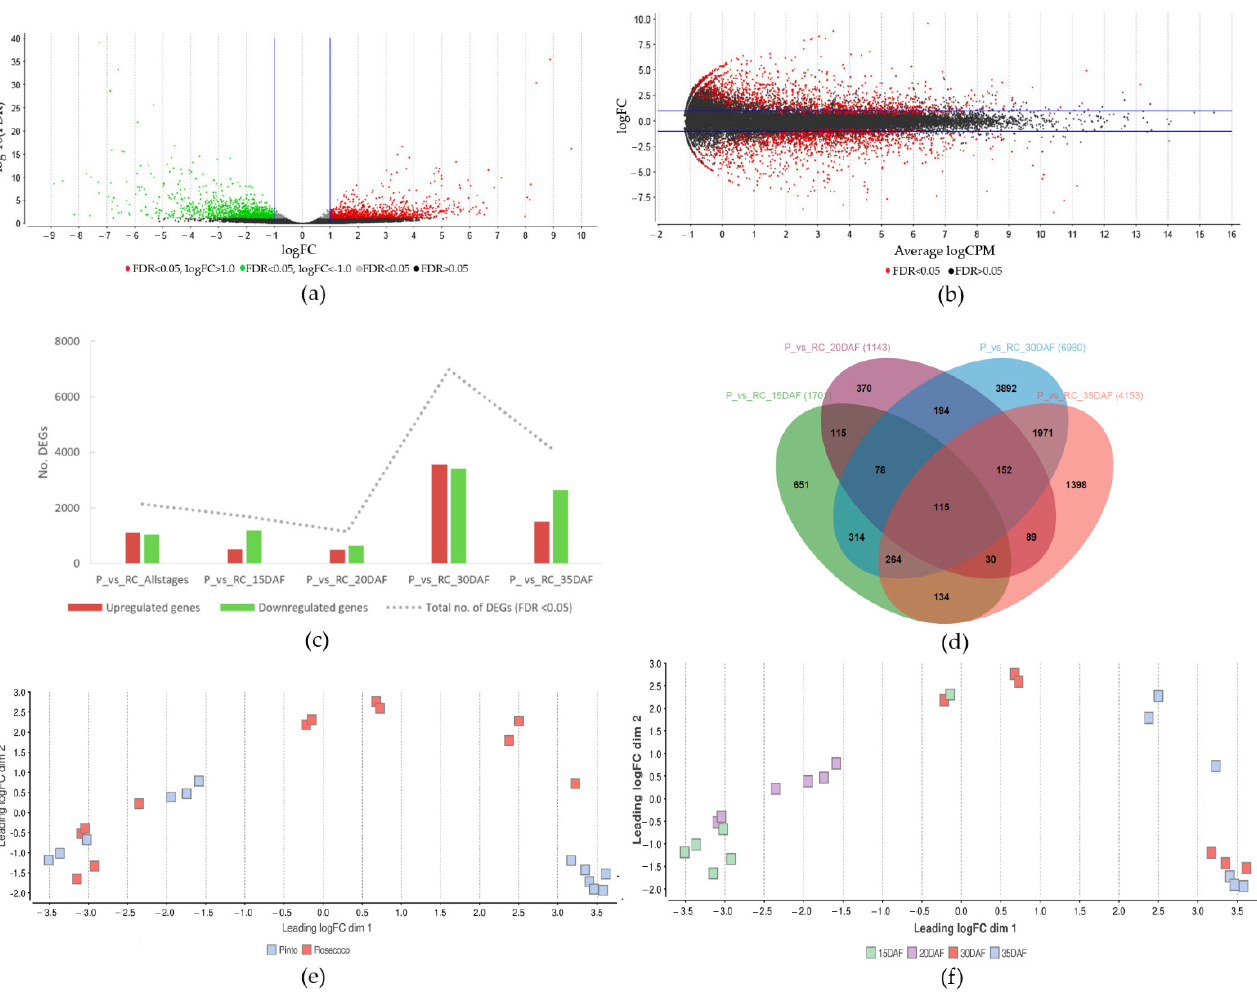
Figure 6. Results of the differential gene-expression analysis showing the distribution of samples and DEGs. ( a ) Volcano plot showing the log2 fold change in expression between slow-cooking beans (Pinto) and fast-cooking (Rosecoco) on the x -axis against the negative Log10 of FDR of the DEGs ( y -axis). Significantly upregulated and downregulated genes are indicated with red and green data points, respectively. Black data points depict nonsignificant DEGs. ( b ) MA plot showing the log2 fold change in expression in fast- and slow-cooking beans ( y -axis) against mean expression level ( x -axis). Red data points depict DEGs that were significant at FDR < 0.05. Black data points had FDR values of >0.05. Blue lines depict the specified thresholds for the log2 fold change in ( a , b ). ( c ) Bar chart showing the number of DEGs in the samples, and ( d ) Venn diagram showing the number of shared DEGs between the samples. ( e ) Multidimensional scaling (MDS) plot showing the pairwise distribution of samples within the different phenotypes of slow-cooking and fast-cooking beans, and ( f ) within the different seed-development stages. Distances on the plot represent log2 fold changes between the